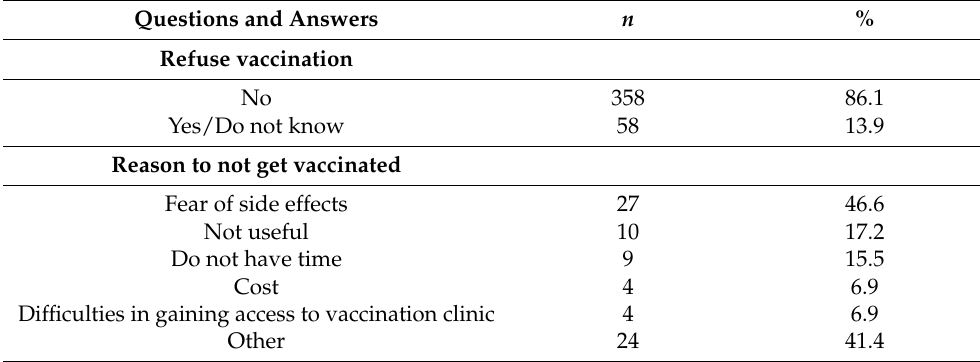
Table 4. Attitudes toward vaccinations.